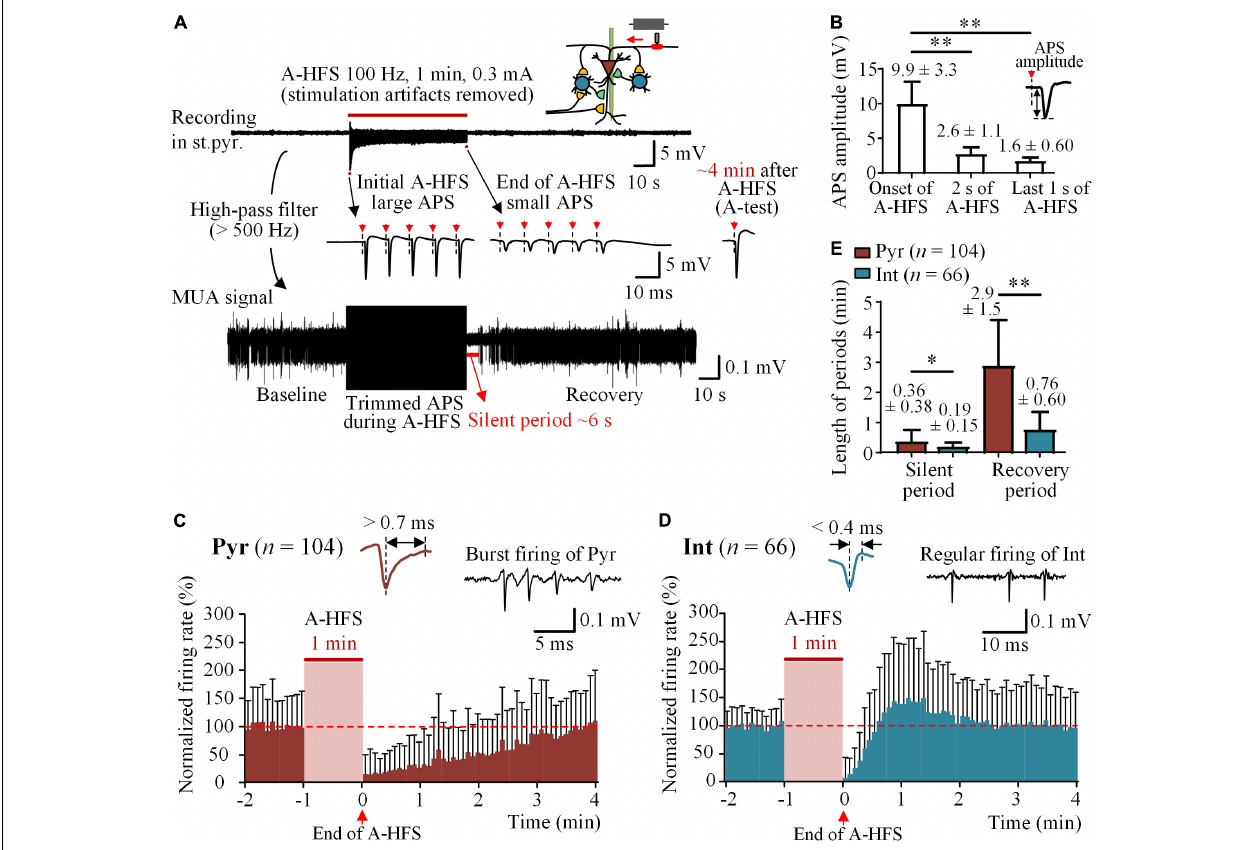
FIGURE 2 | Silence of neuronal firing following A-HFS. (A) Top : a typical recording of neuronal potentials before, during, and after 1-min 100 Hz A-HFS in the stratum pyramidale (st.pyr.) of hippocampal CA1 region. A schematic diagram of stimulation and recording is shown on the upper-right corner. Middle : The expanded signals show the initial large APS and the end small APS evoked by the pulses of A-HFS. The red arrows with dashed lines denote the artifacts of pulse stimuli. Bottom : The MUA signal obtained by filtering the original recording shows the firing of unit spikes before and after A-HFS. (B) Comparisons of amplitudes of APSs evoked at the onset, 2 s, and the last 1 s of A-HFS. ∗∗ P < 0.01, repeated one-way ANOVA with post hoc Bonferroni tests, n = 40 rats. (C,D) Time histograms of mean normalized firing rate of pyramidal cells (Pyr) and interneurons (Int) before and after A-HFS (time bin = 5 s). Typical spike waveforms and firing patterns of the two types of neurons are illustrated on the top. The red dashed lines denote the mean baseline firing rate, i.e., 100%. Because of the differences in the lengths of silent period of individual neurons, with some silences shorter than 5 s, a clear silent period with zero firing cannot appear in the histograms of mean firing rates of neurons with a bin of 5 s. (E) Comparisons of the lengths of silent period and recovery period following A-HFS between pyramidal cells and interneurons. ∗ P < 0.05, ∗∗ P < 0.01, unpaired t